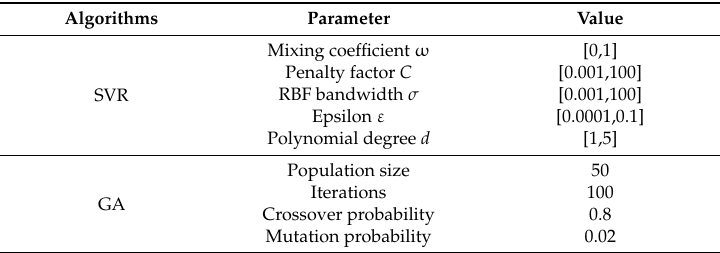
Table 1. Parameters of SVR and GA.